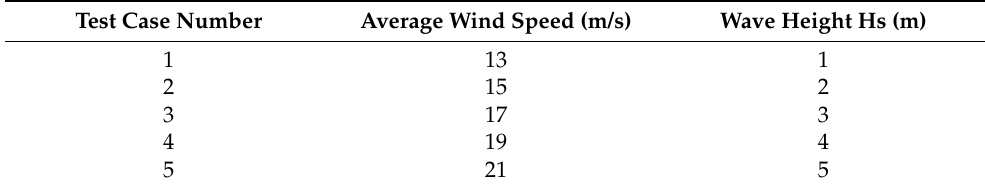
Table 2. Test simulation cases.